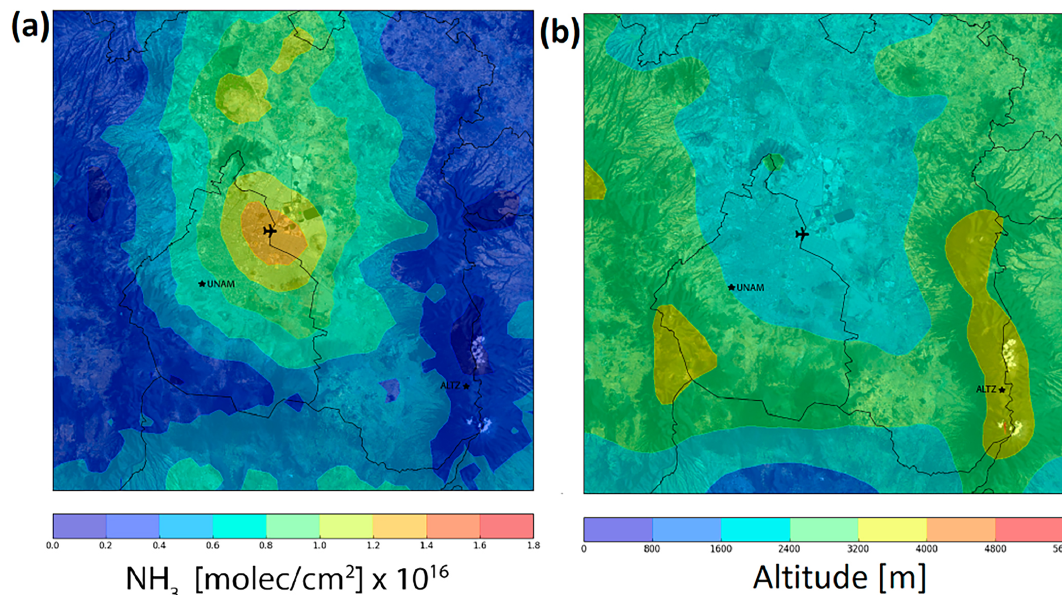
Figure 8. Spatial distribution of (a) IASI-A NH 3 total columns for the morning overpass of MetOp-A over Mexico City, averaged over 2008–2018 (b) altitudes in Mexico City from the Space Shuttle Radar Topography Mission Global product City (SRTMGL3, Farr et al., 2007). The black stars indicate the location of ground-based stations, and Mexico City International Airport is shown for reference.